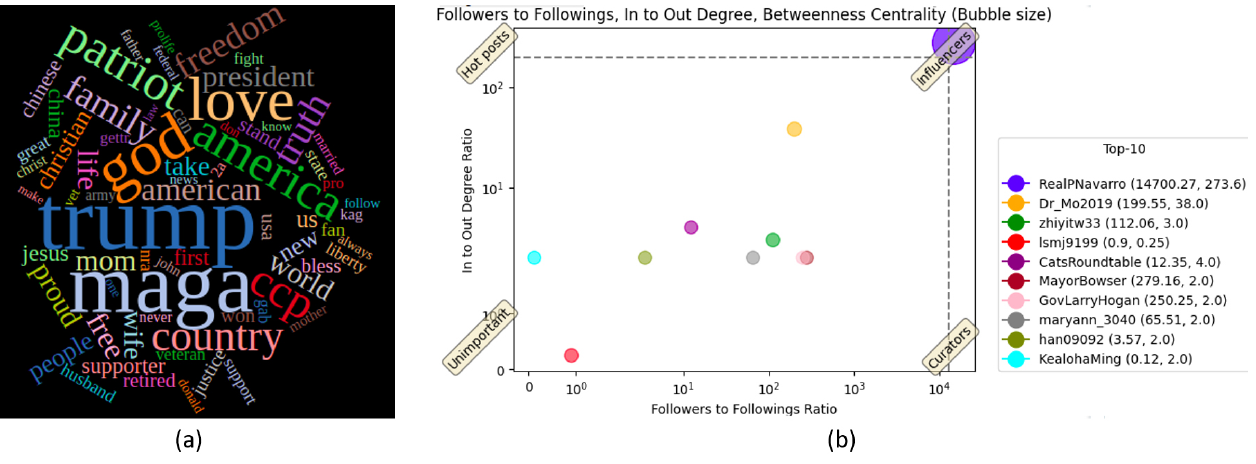
Figure 8. Results of Fauci use-case analysis: ( a ) word cloud of Community 3 and ( b ) centrality plot of Community 3 indicating that Peter Navarro’s account stands as an influencer in the community.